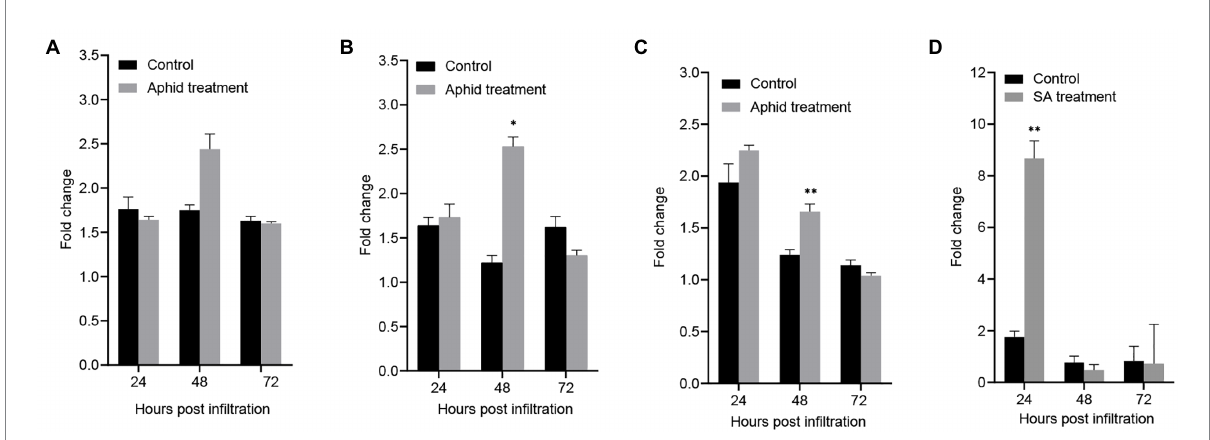
FIGURE 2 Expression of GhCalS5 in cotton plants after cotton aphid treatment and after SA treatment. (A) Root after aphid treatment, (B) stem after aphid treatment, (C) leaf after aphid treatment (D) leaf after SA treatment. Error bars represent the standard deviation of measurements from three